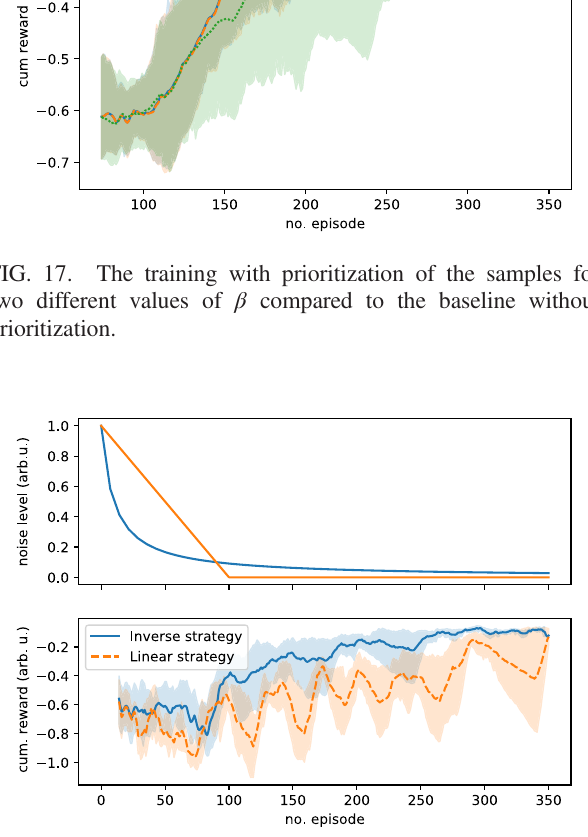
random noise as function of episode and the lower plot the cumulative reward per episode obtained for training with five different seeds. The inverse strategy results in a more stable training.